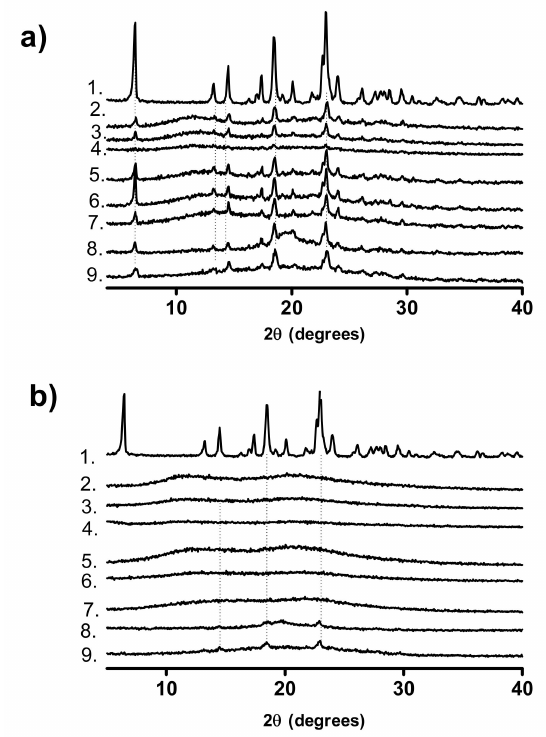
Figure 6. pXRD patterns of ( a ) Physical mixtures of crystalline ketoprofen and polymers, ( b ) Melt-quenched and cryo-milled POLYMERKETO. 1. Crystalline ketoprofen, 2. PVP90KETO,